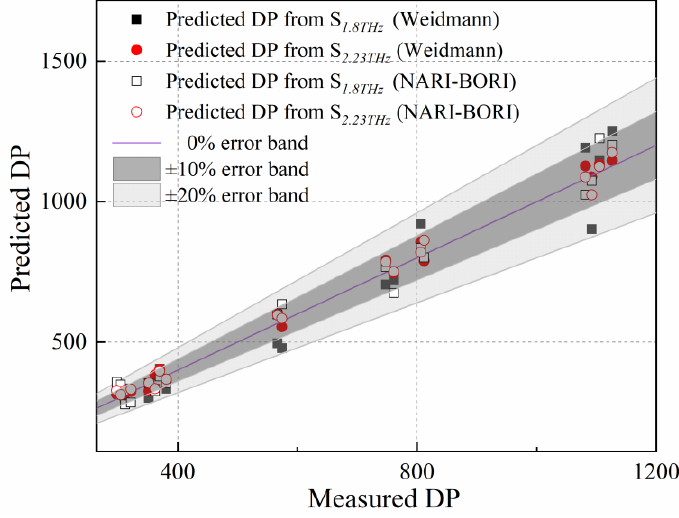
Figure 7. Predicted DP and error band of evaluation model applied in two types of insulating paper obtained from the Weidmann and NARI-BORI companies.